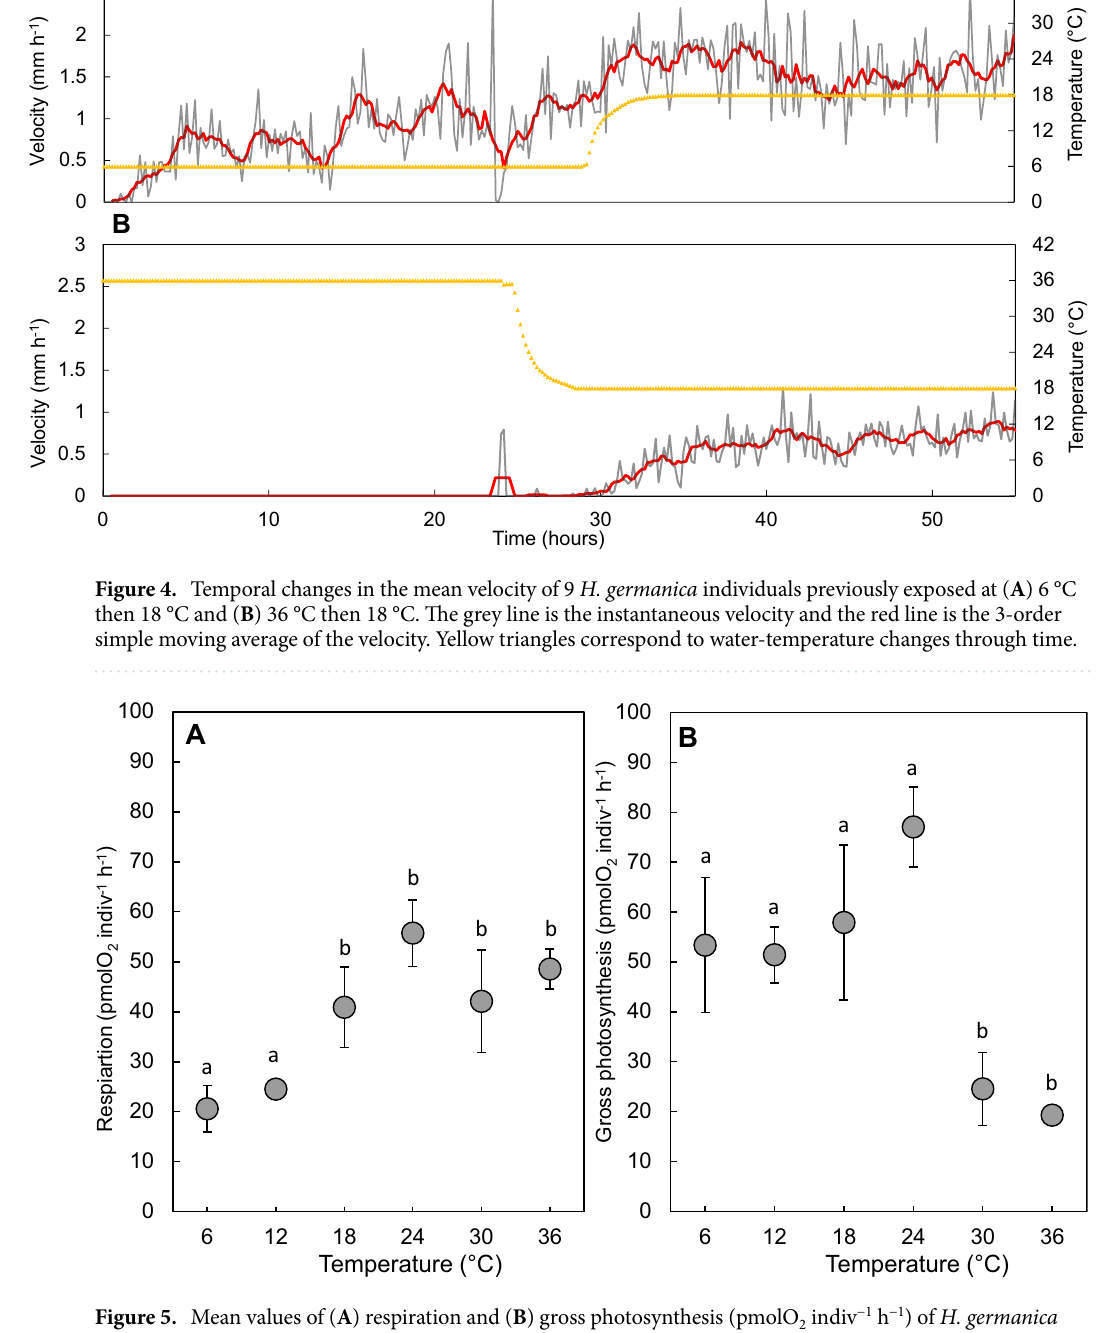
Figure 5. Mean values of ( A ) respiration and ( B ) gross photosynthesis (pmolO 2 indiv −1 h −1 ) of H. germanica under different thermal regime in 3 replicate measurements. The error bars are the standard errors of the mean. Letters ‘a’ and ‘b’ identify significant different groups (Tukey test, p <